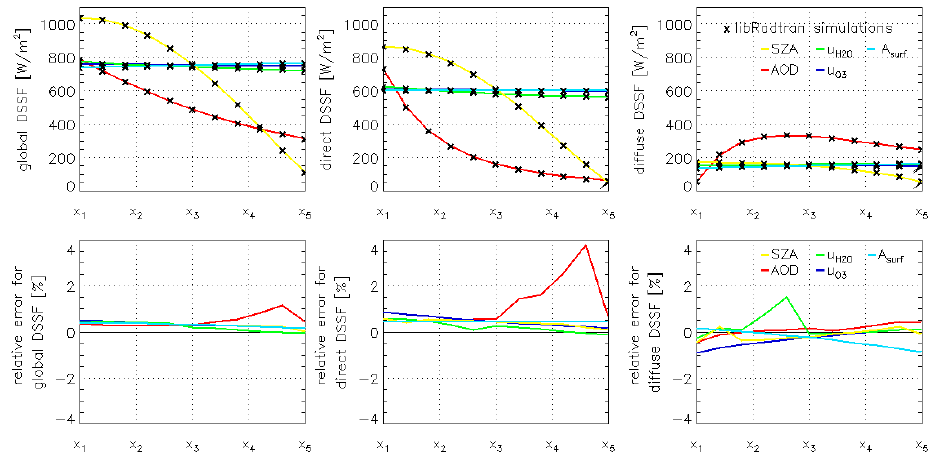
Figure 4. (top): global, direct, and diffuse DSSF values computed with SIRAMix according to varying AOD (red color), ozone content (dark blue color), water vapor concentration (green color), SZA (yellow color), and surface albedo (light blue color). Coincident DSSF simulations with libRadtran are shown with black crosses. (bottom): Relative error for global, direct, and diffuse DSSF values when compared to libRadtran simulations. Horizontal axis ticks ( x 1 , x 2 , x 3 , x 4 , x 5 ) correspond to (0, 1, 2, 3, 4) for AOD, to (0, 125, 250, 375, 500) in Dobson units for ozone, to (0., 1.25, 2.5, 3.75, 5.0) in gcm − 2 for water vapor, to (0, 20, 40, 60, 80) in degrees for SZA, and to (0.0, 0.1, 0.2, 0.3, 0.4) for surface